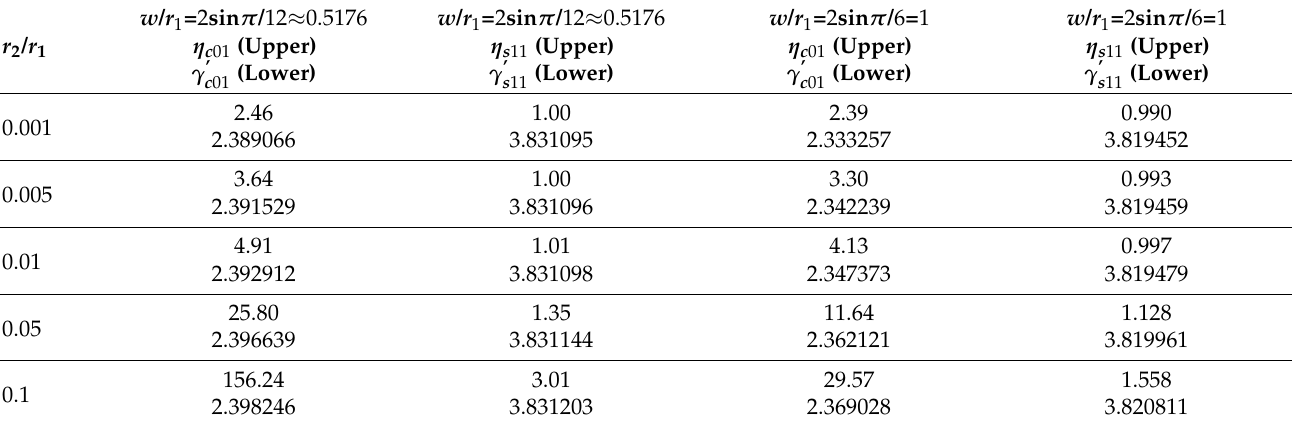
Table 3. Influence of the PEC rod on complex eigenvalues of the open circular cavity.